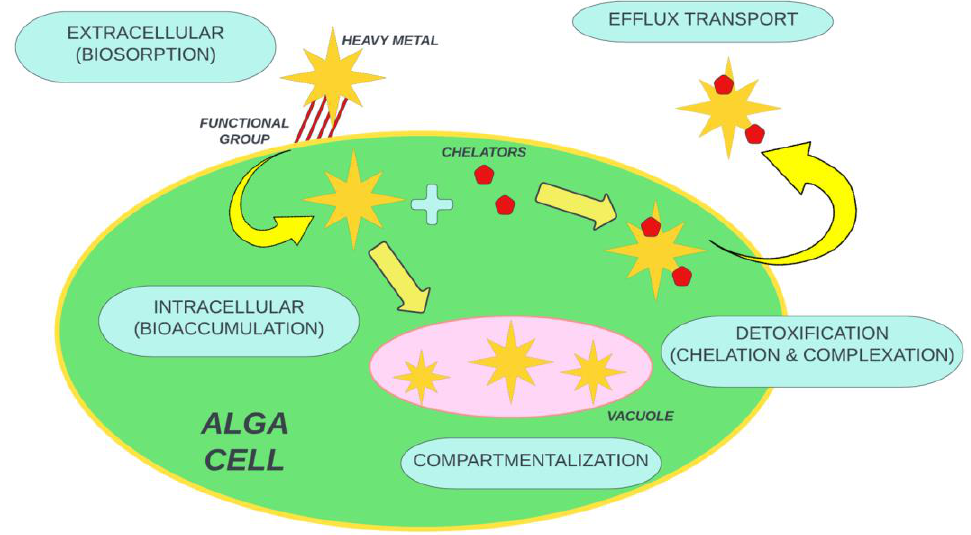
Figure 2. General eradication mechanism of toxins by